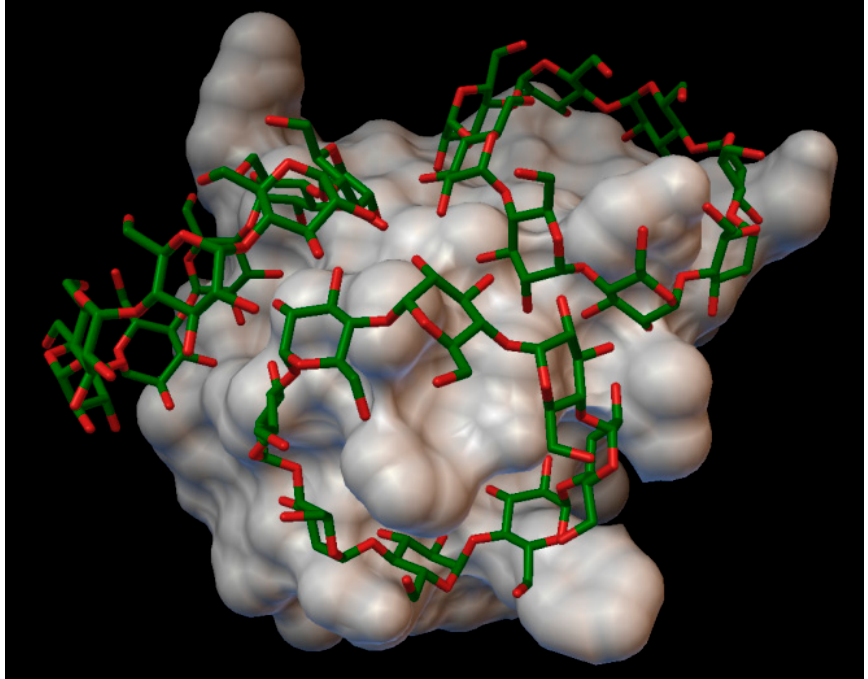
Figure 6. Insulin- γ -cyclodextrin complex. The insulin molecular surface is marked with white, and the cyclodextrin molecules are marked with green and red licorice.